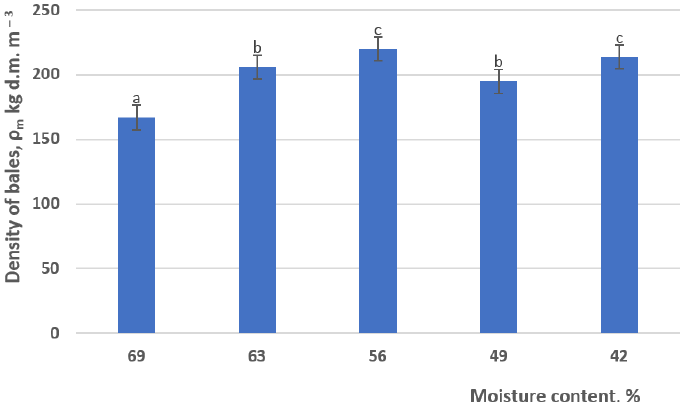
Figure 7. Bar chart of balage density in bales at different moisture content levels at a pressing pressure of 14 MPa and plant material at a length of 183 mm. Different lowercase letters indicate a statistically significant difference at p ≤ 0.05. d.m., dry matter.